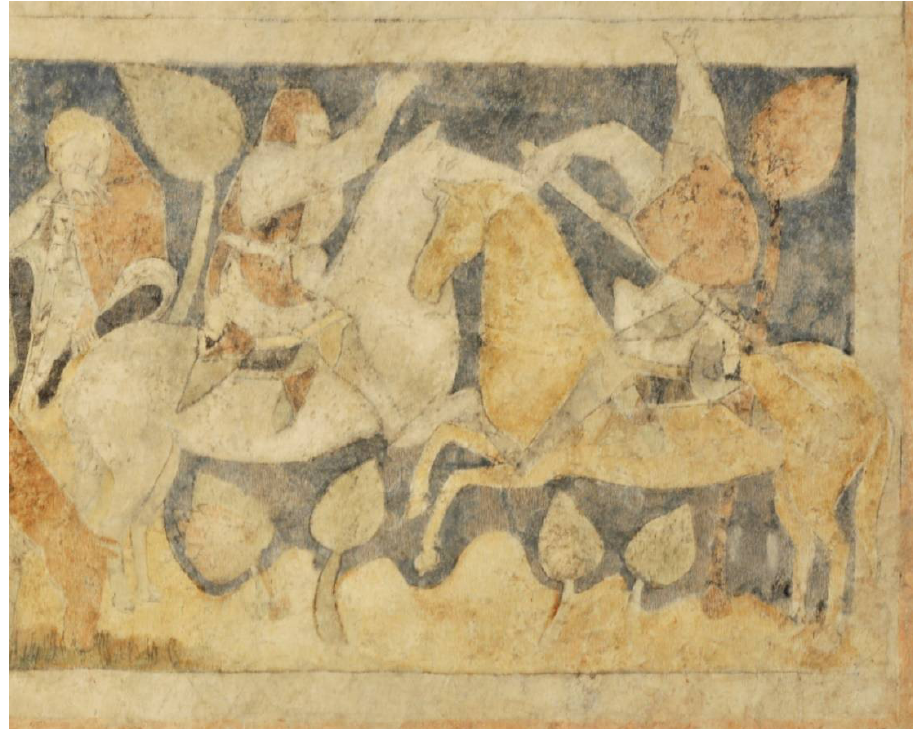
Figure 25. Siedlęcin, Siedlęcin, ducal tower, Great Hall. Detail of legend of Lancelot (Lancelot in a Figure 25. Siedl˛ecin, Siedl˛ecin, ducal tower, Great Hall. Detail of legend of Lancelot (Lancelot in duel with Tarquyn). First half of the 14th century. Photo by Przemysław Nocuń, the author’s own a duel with Tarquyn). First half of the 14th century. Photo by Przemysław Nocu´n, the author’s work. own